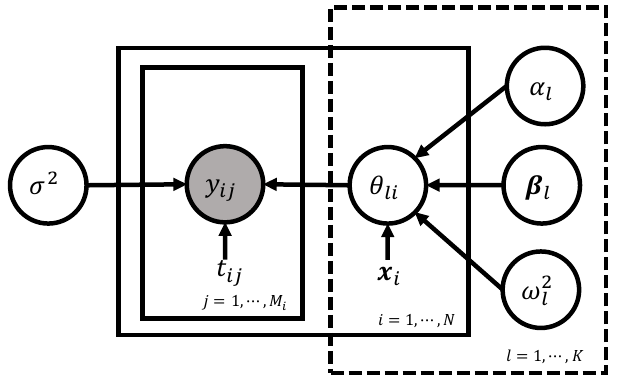
Figure 8. The basic model (2)–(4) as a graphical